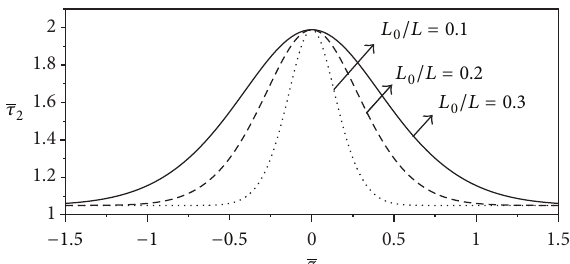
Figure 9: Variations of skin friction 𝜏 2 with axial distance for different values of stenosis size 𝐿 0 /𝐿 .